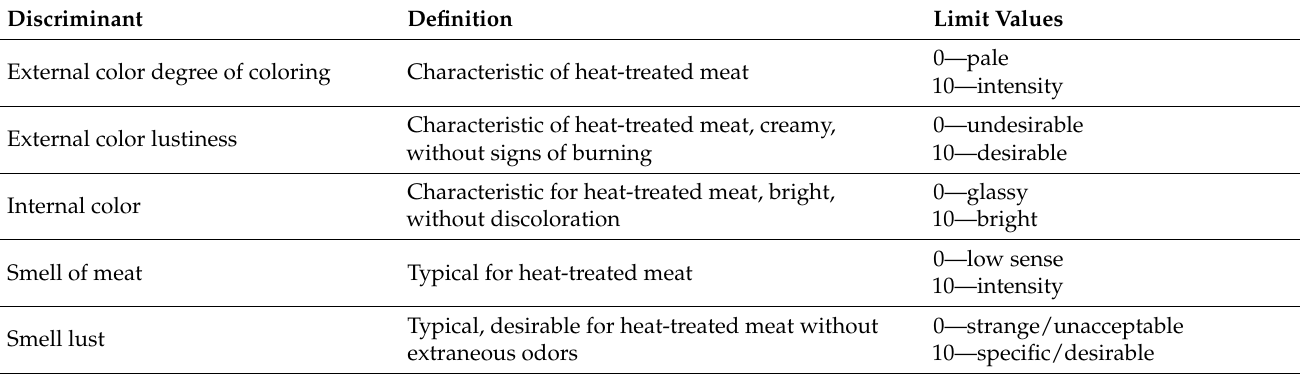
Table 3. Distinguishing features and their definitions for the profile method of meat fillet samples chicken